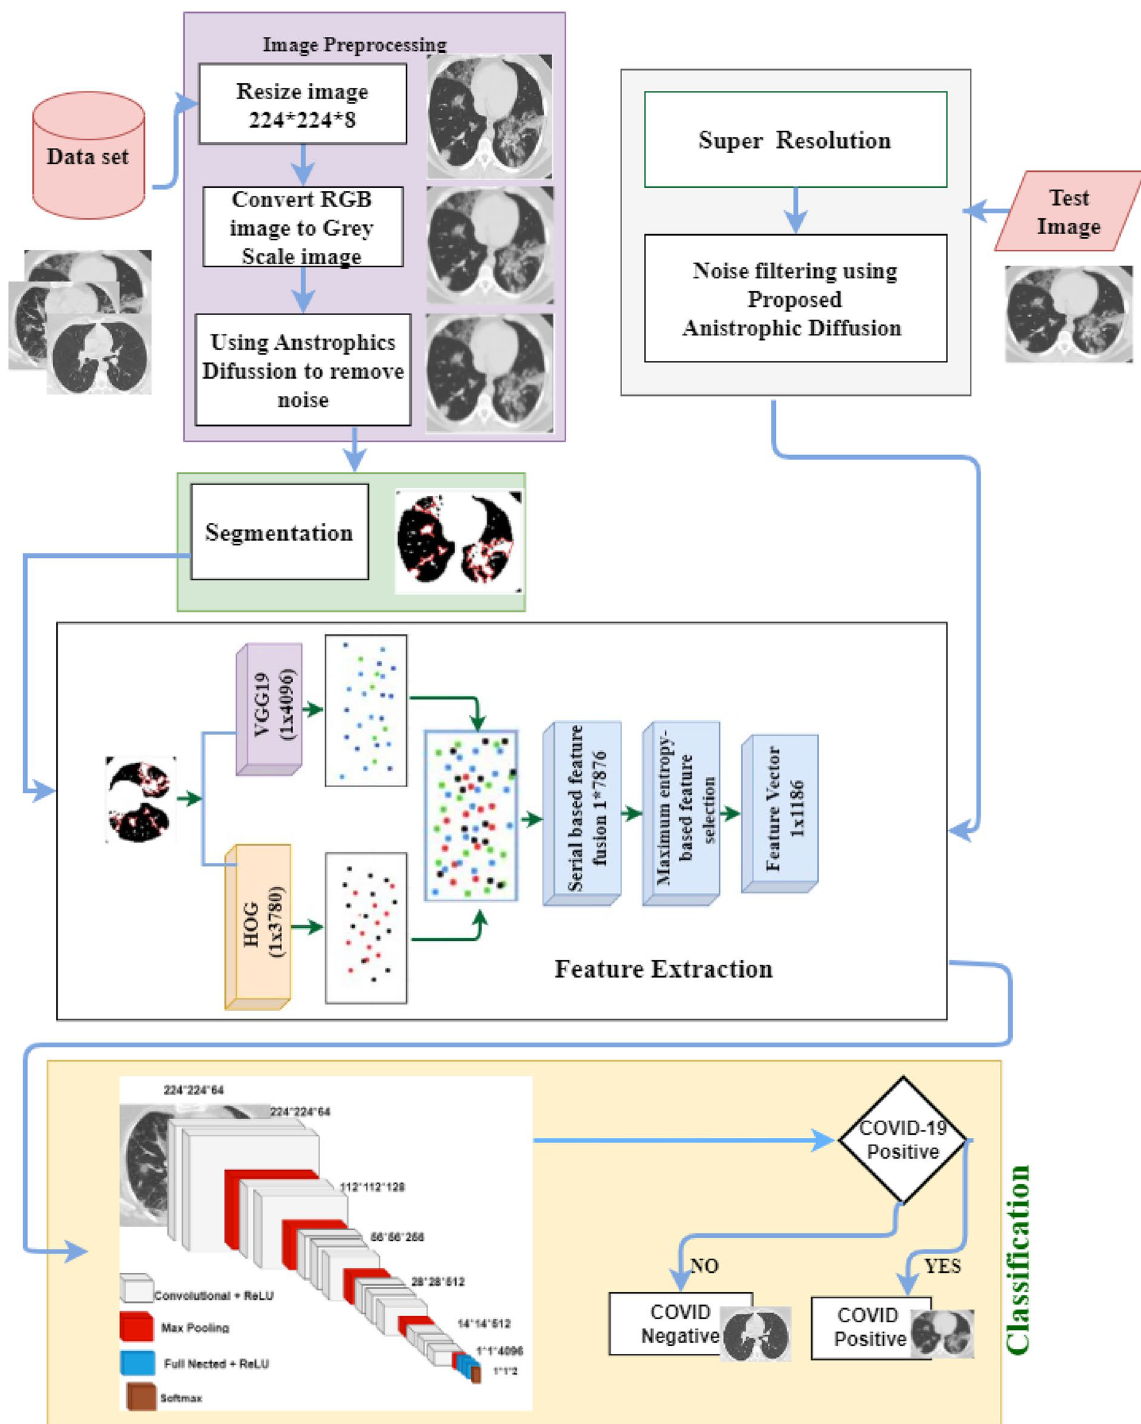
Figure 1. Workflow diagram of proposed VGGFusionNet